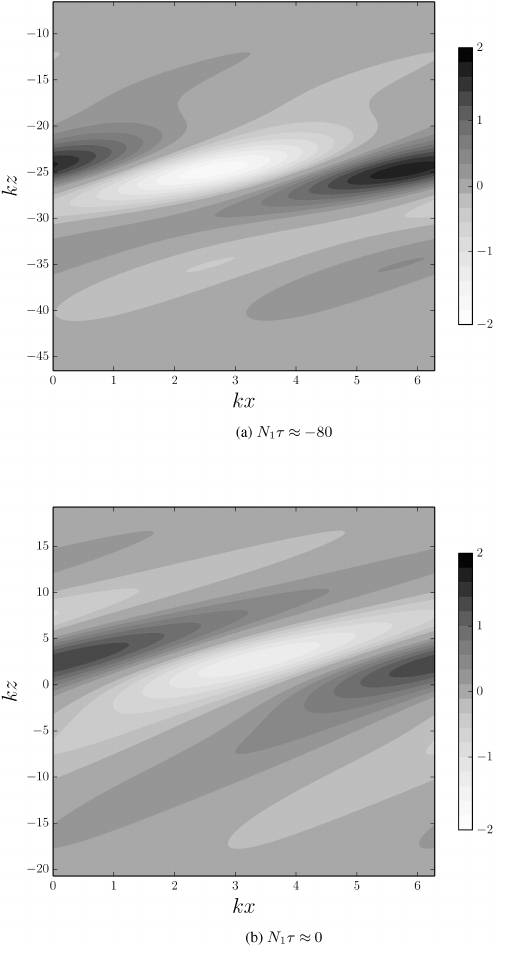
Figure 5. Contours of vertical velocity in a single layer of constant N with n 1 /k = 0.4, (cid:15) = 0.025, and α = 0.1.